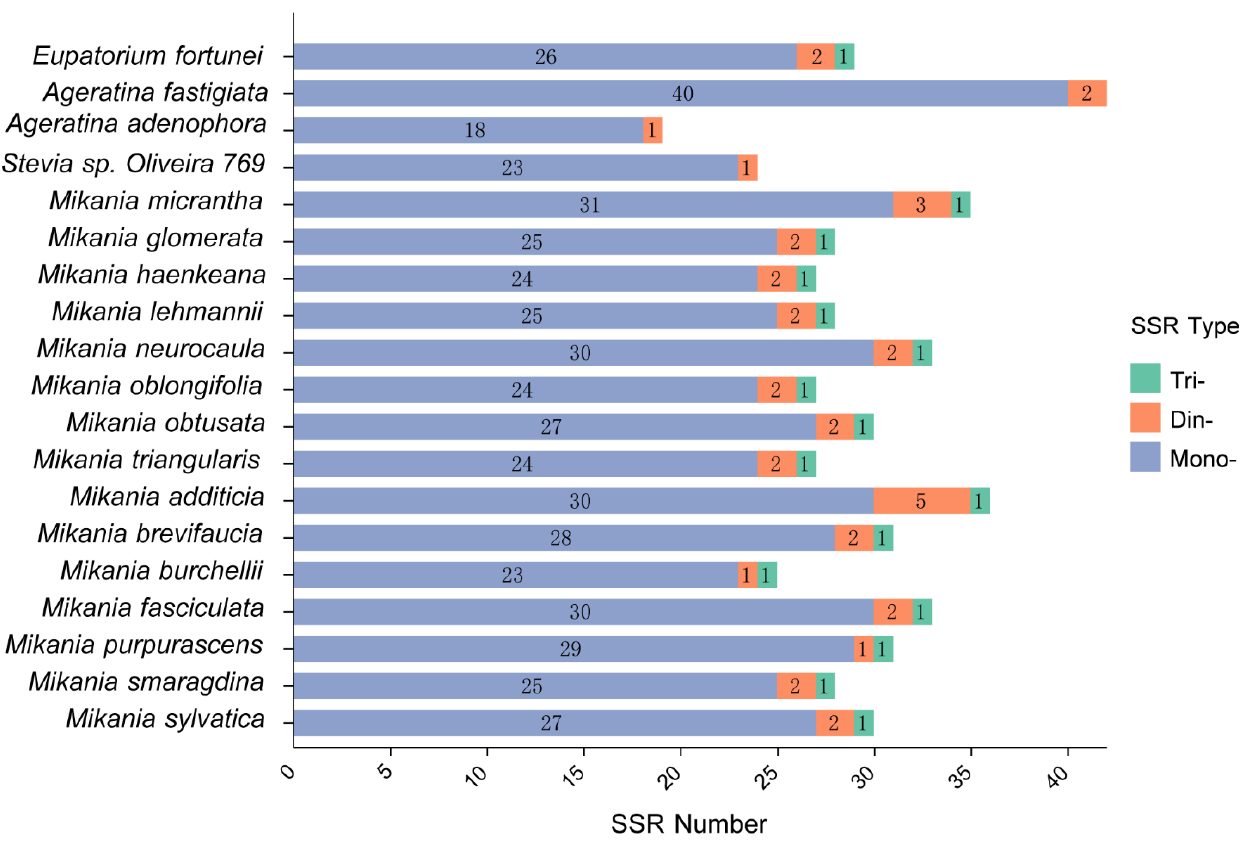
Figure 2. Analysis of simple sequence repeat (SSR) in the chloroplast genomes of 20 Eupatorieae species. The x -axis represents the numbers of SSR in each chloroplast genome. The y -axis represents 20 Eupatorieae species. Mono-, mono-nucleotide repeat; Di-, dinucleotide repeat; Tri-, trinucleotide repeat; Tetra-, tetranucleotide repeat.